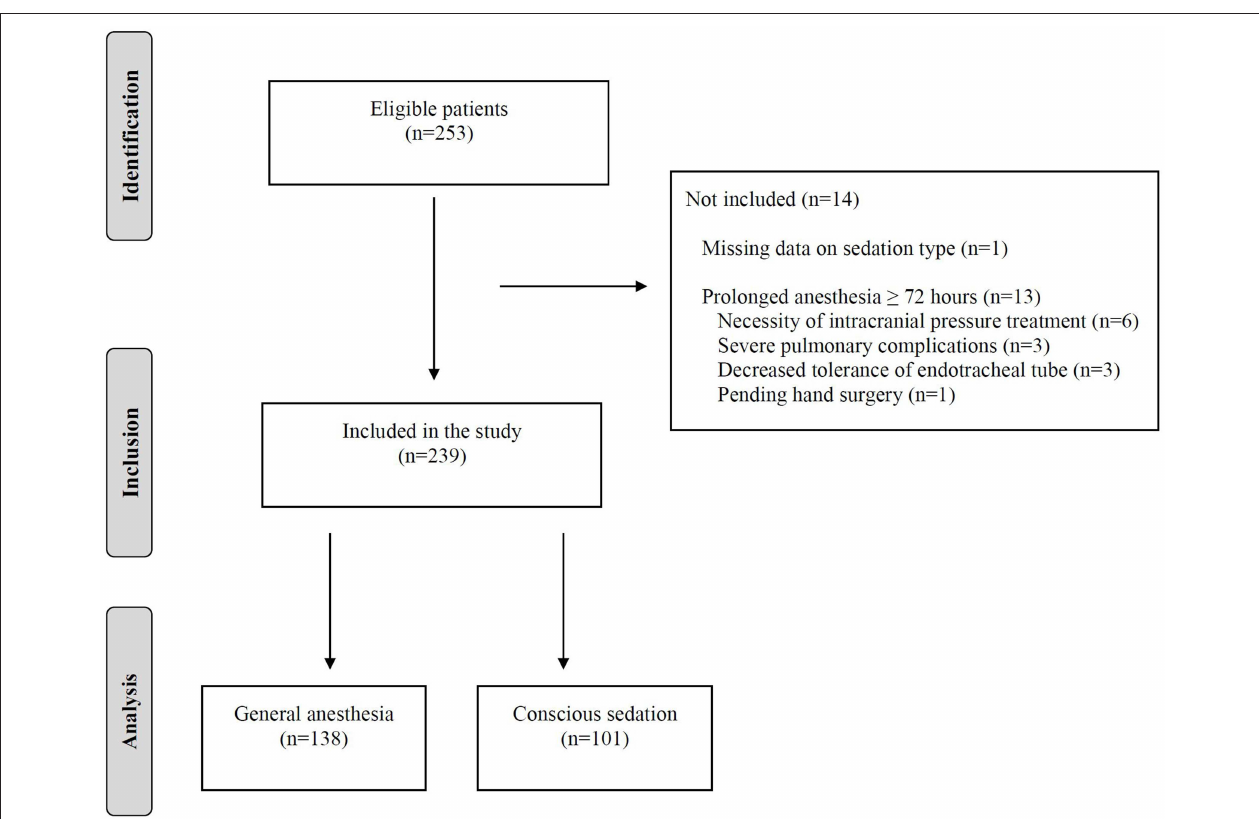
FIGURE 1 | Study flow